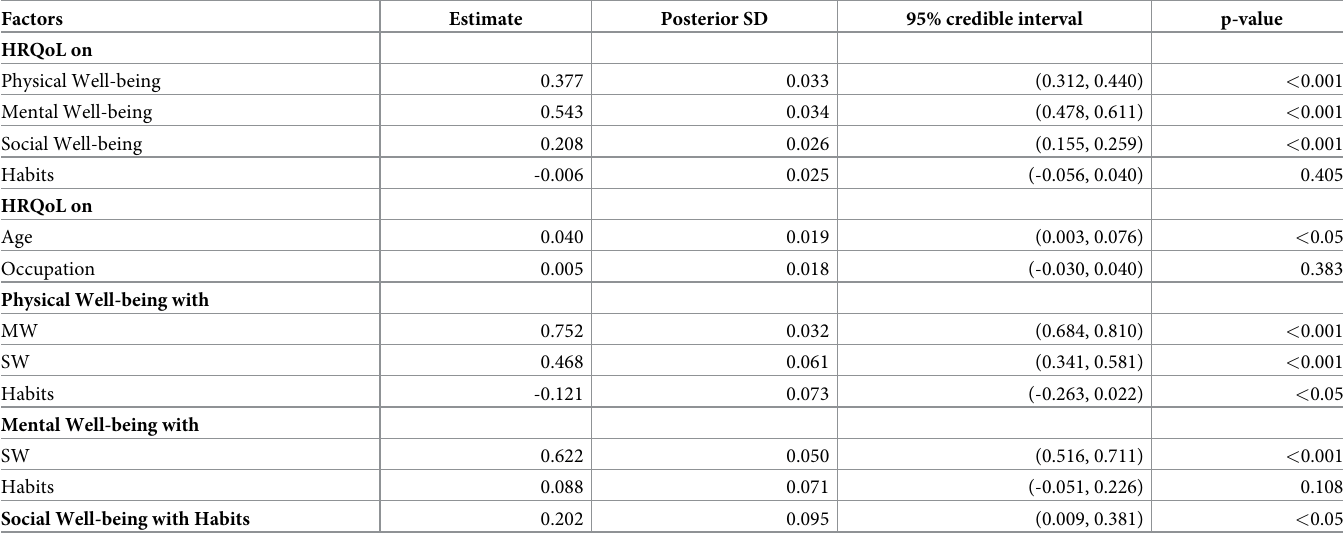
The standardized estimate of physical, mental and social well-being on the variable percentage of total quality of life were 0.377 (p < 0.001), 0.543 (p < 0.001) and 0.208 (p < 0.001) respectively. Table 3. Parameter estimates of structural model for HRQoL of TB